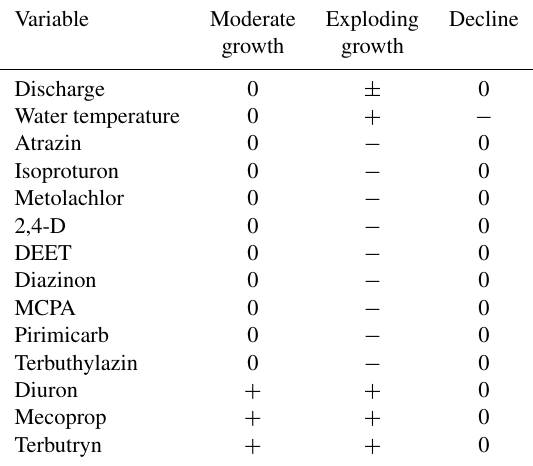
Table 5. Signs of change for future physical parameters and mi- cropollutant concentrations considering socio-economic scenarios only (assuming present climate + CurrPrac). Notation is the same as for Table 4. + : general increase; − : general decrease; ± : quantile- specific response; 0: no